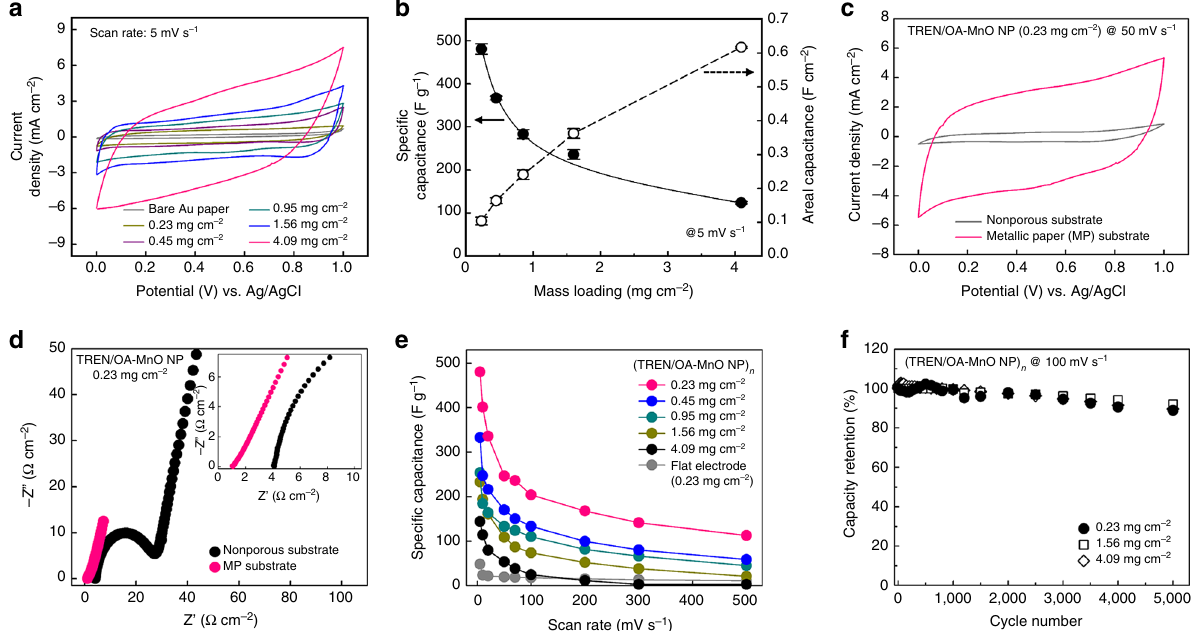
Fig. 3 Electrochemical properties of the MP-based (TREN/OA-MnO NP) n electrode. a Cyclic voltammograms (CVs) of the (TREN/OA-MnO NP) n -coated MP electrodes as a function of the mass loading of MnO NPs (mg cm − 2 ) at a scan rate of 5 mV s − 1 . b Speci fi c and areal capacitances of the (TREN/OA- MnO NP) 20.5 -coated MP electrodes as a function of the mass loading of MnO NPs (from 0.23 to 4.09 mg cm − 2 ). c CVs of the (TREN/OA-MnO NP) n - coated MP and nonporous substrate (Au-coated Si wafer) electrodes with a mass density of 0.23 mg cm − 2 at a scan rate of 50 mV s − 1 . d Nyquist plots of the (TREN/OA-MnO NP) n -coated MP and nonporous substrate nonporous substrate (Au-coated Si wafer) electrodes. e Scan rate dependence of the speci fi c capacitance of the (TREN/OA-MnO NP) n -coated MP electrodes with different mass densities. f Cycling retention of the (TREN/OA-MnO NP) n - coated MP electrodes with mass densities of 0.23, 1.56 and 4.09 mg cm − 2 ,